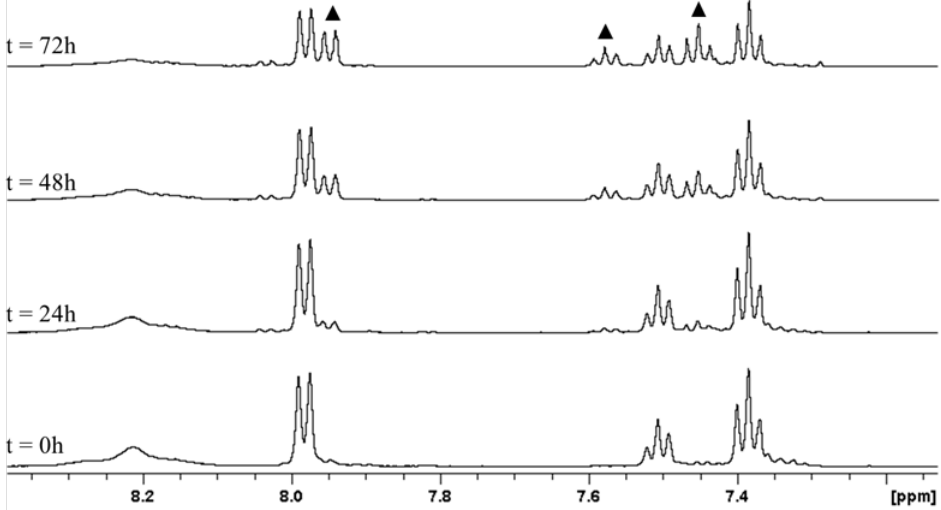
Figure 4. Portion of the 1 H-NMR (500 MHz) spectra of complex 1 in Acetone-d 6 acidified with DCl (pH = 1.5), acquired at different time intervals. Free benzoate peaks are marked with black triangles.